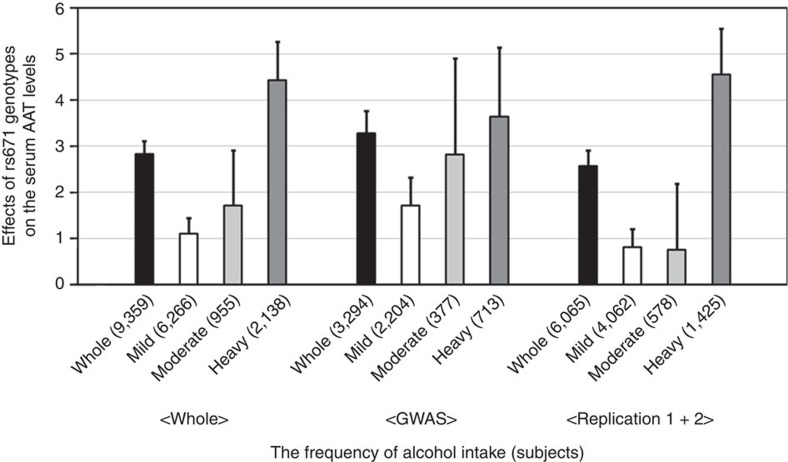
The interaction between the rs671 genotypes and alcohol drinking on the serum AAT levels.The effects of rs671 on serum AAT levels in linear regression analysis are shown in the groups subdivided into three groups based on alcohol intake. Error bars represent standard errors.